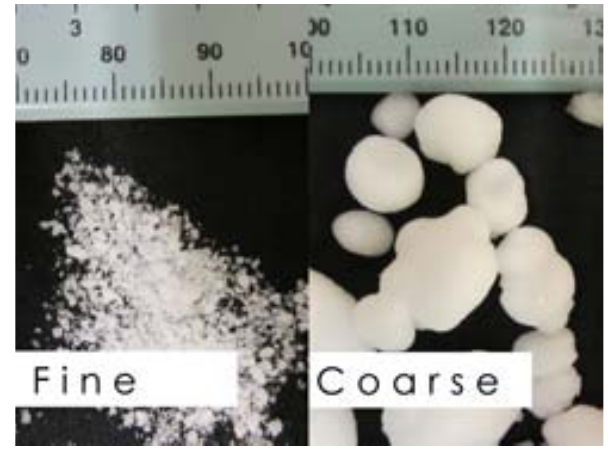
Fig. 2. Photographs of the artificial snow samples taken immedi- ately after